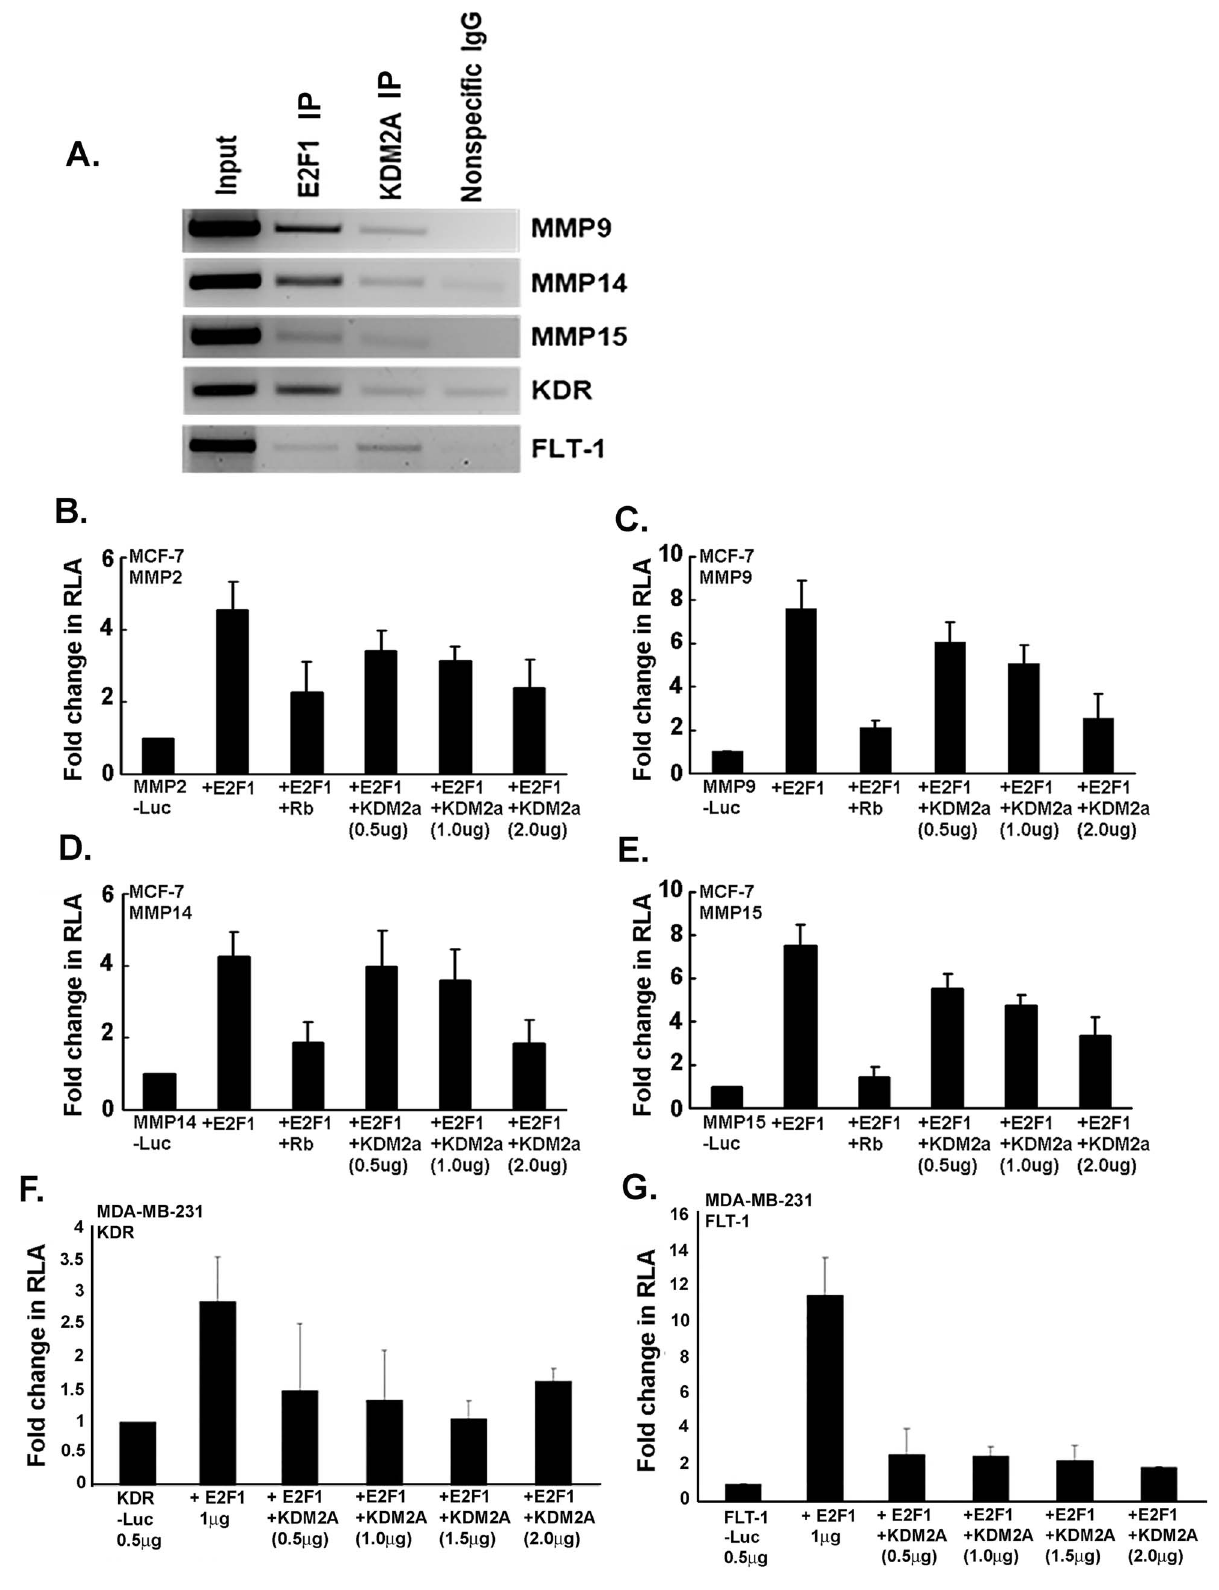
Figure 6. KDM2A represses transcriptional activity of MMPs and VEGF receptors by inhibiting E2F1-mediated transcription. (A) ChIP assay demonstrates occupancy of KDM2A on MMP9, -14, -15, KDR and FLT-1 similar to E2F1. (B, C, D, E) Transient transfection experiments in MCF-7 cells showed that E2F1 induces MMP2 (B), MMP-9 (C), MMP-14 (D) and MMP-15 (E) promoters, and this was repressed by co-transfection of KDM2A or